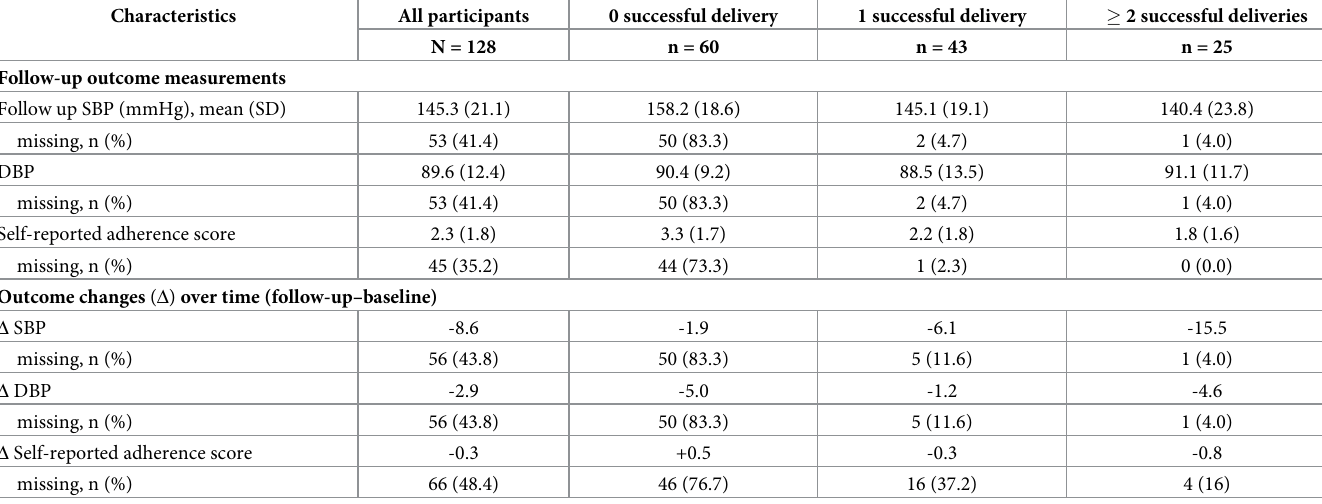
Table 2. Follow-up blood pressure measurements and self-reported adherence scores, stratified by number of delivery attempts.